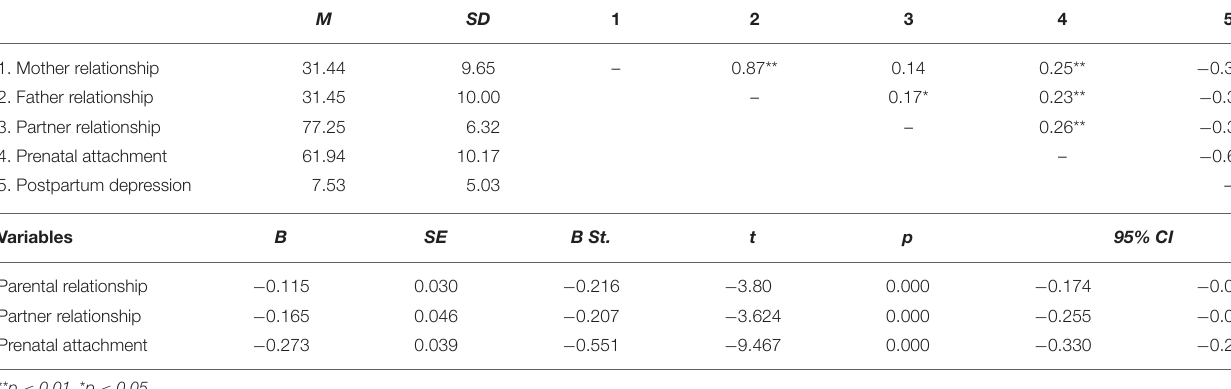
TABLE 3 | Descriptive statistics, correlations and summary of the linear regression analysis with the quality of parental, romantic and prenatal relationships as independent variables for PPD score.